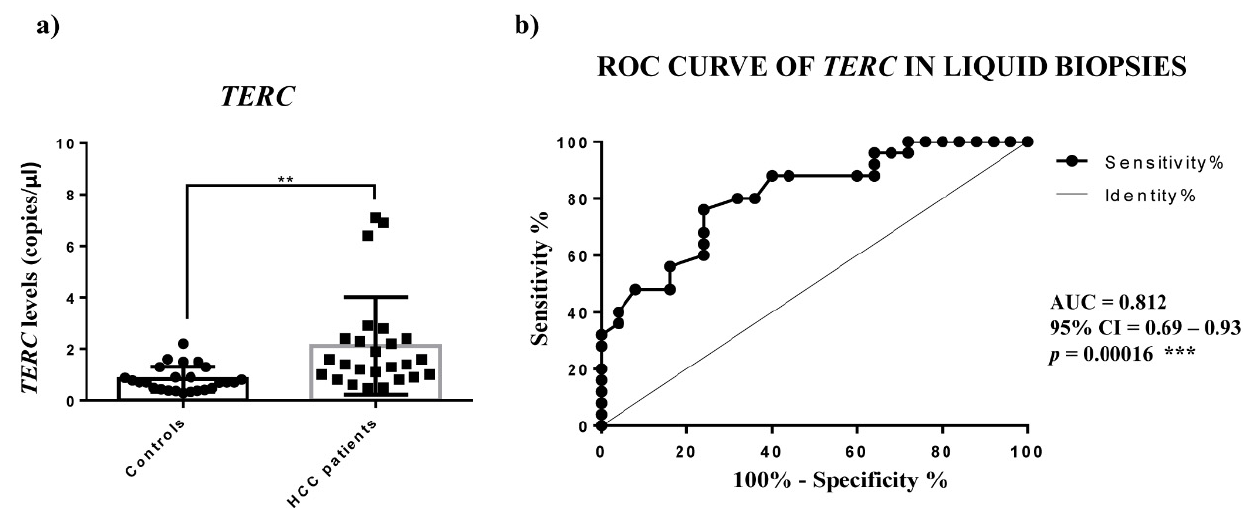
Figure 5. Plasma levels of TERC . ( a ) TERC levels in terms of copies/ μ L in plasma of control subjects (C) and HCC patients. Unpaired t -test was used. ( b ) ROC curve analysis of TERC to discriminate HCC from healthy individuals. ** p < 0.01; *** p < 0.001.